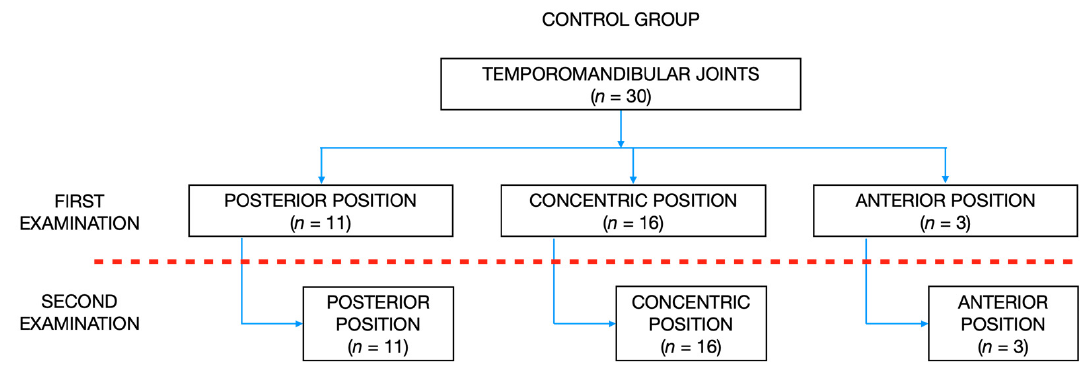
Figure 4. The distribution of condylar sagittal positions within the glenoid fossae in the control group during initial and second examination.